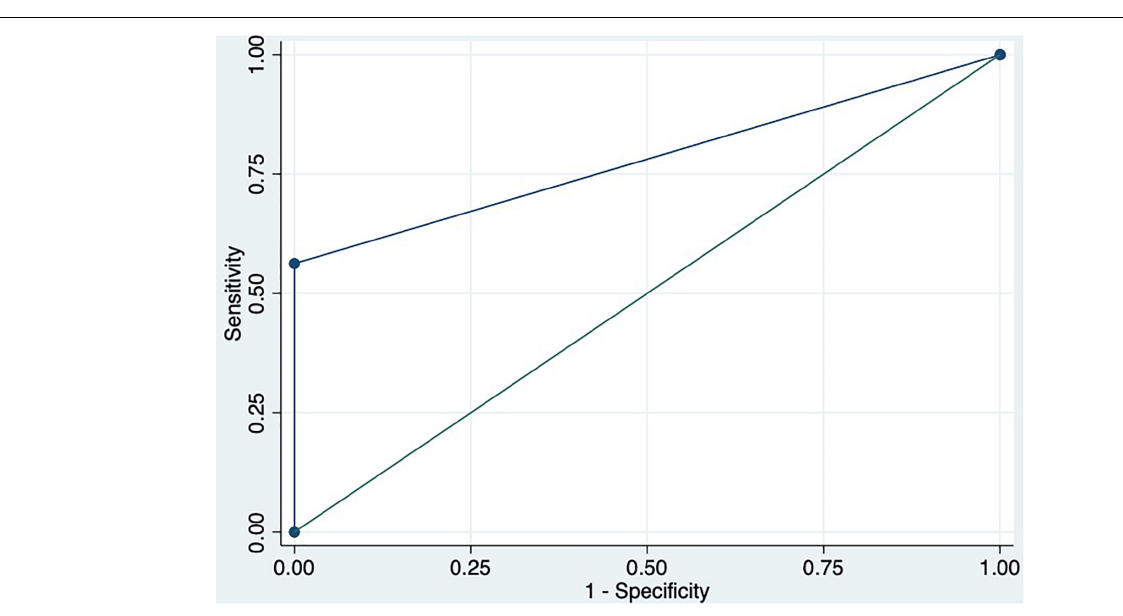
FIGURE 5 | ROC curve of the combination of spleen TE ≥ 74 KPa and damping index > 0.6 to predict chronic response to